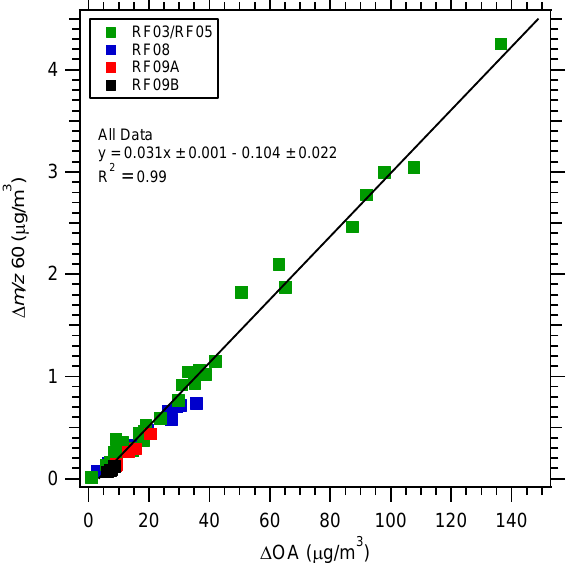
Figure 7. Correlation of 1m/z 60 vs. 1 OA for all flights with the data segregated by fire location. Uncertainty with the least-square regression is one standard